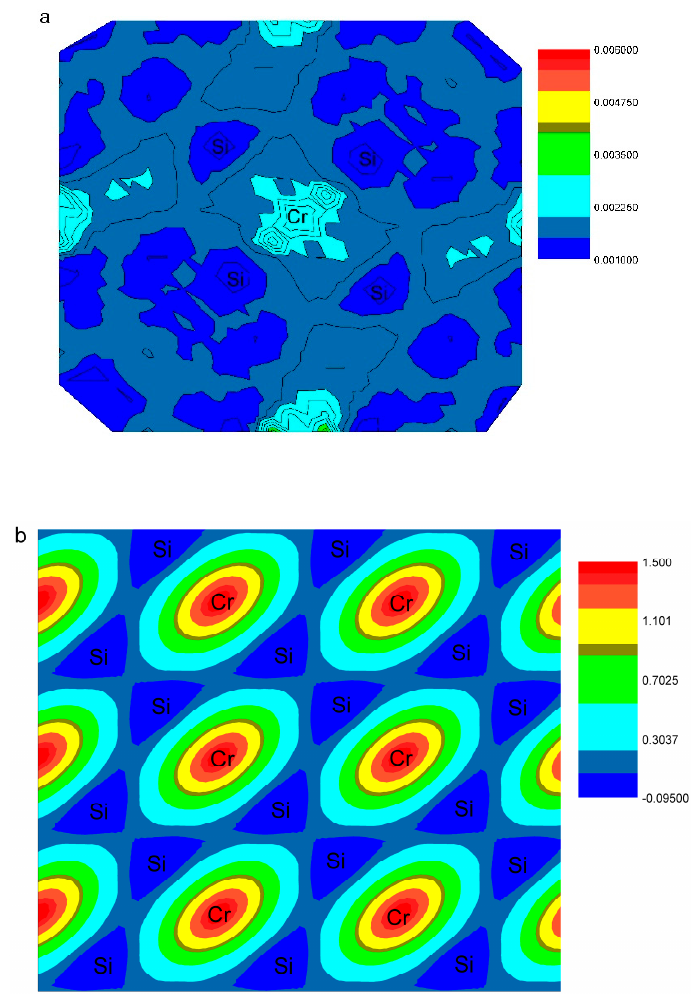
Figure 5. Spin density iso-surface plots of ( a ) bulk and ( b ) monolayer CrSi 2 on top view (001). The iso-surface level is set as 0.003e/Å 3 .